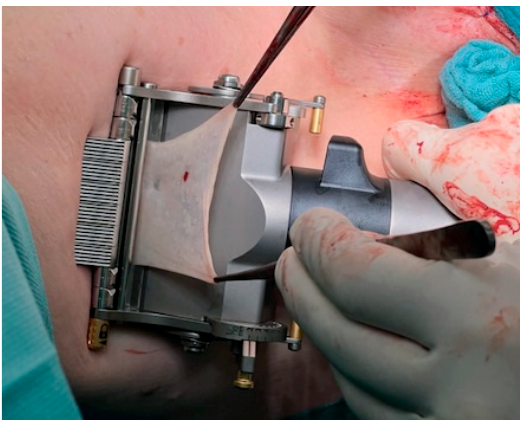
Figure 3. Harvesting the split-skin graft with split-skin dermatome, driven by compressed air.